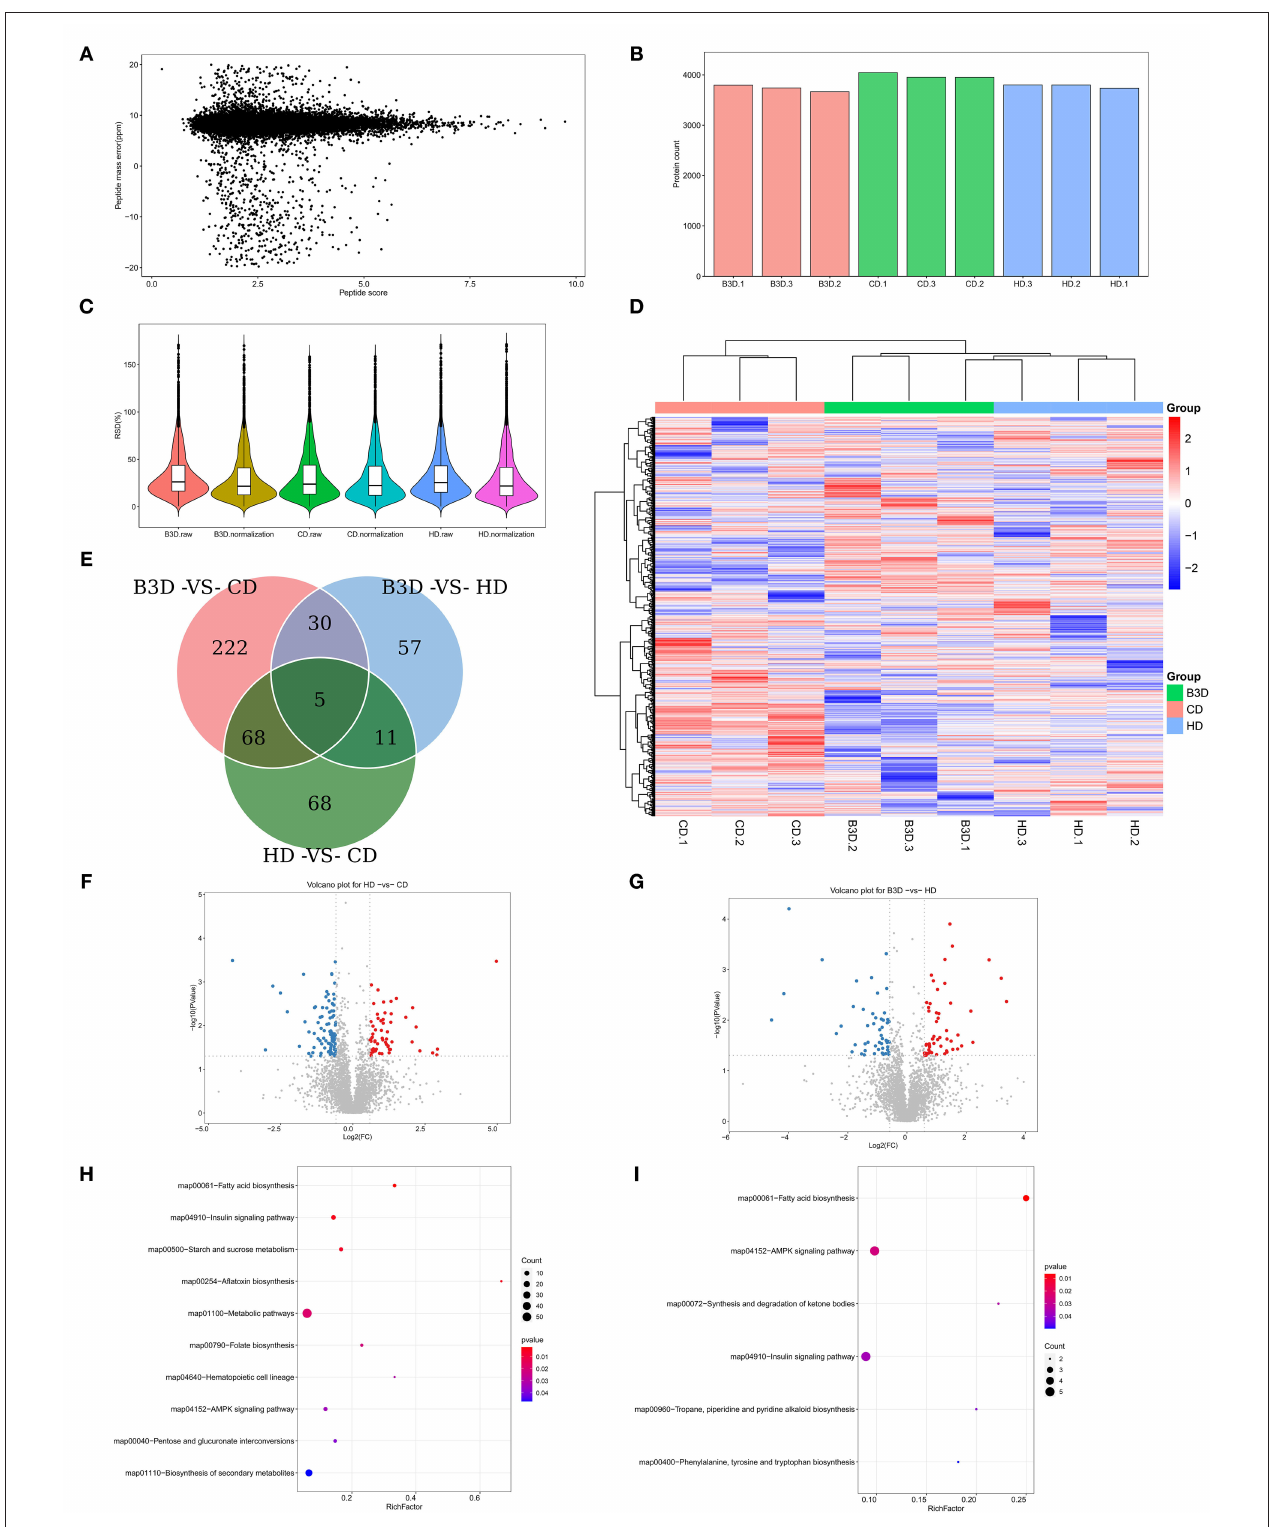
FIGURE 4 | The basal proteomic profile analyses of the liver in CD, HD, and B3D groups. (A) The mass error of all detected peptides ( n = 3). The X -axis represents the score of the peptide segment (the higher the better); the Y -axis represents the mass error (the smaller the better). (B) The number of identified proteins in all samples. (C) The comparison of CV before and after the normalization of identified proteins. CV (coefficient of variance) is the ratio of standard deviation to the mean of the abundance of proteins. After normalization, the CV decreased significantly, and lower CV means better overall repeatability of the sample. (D) The